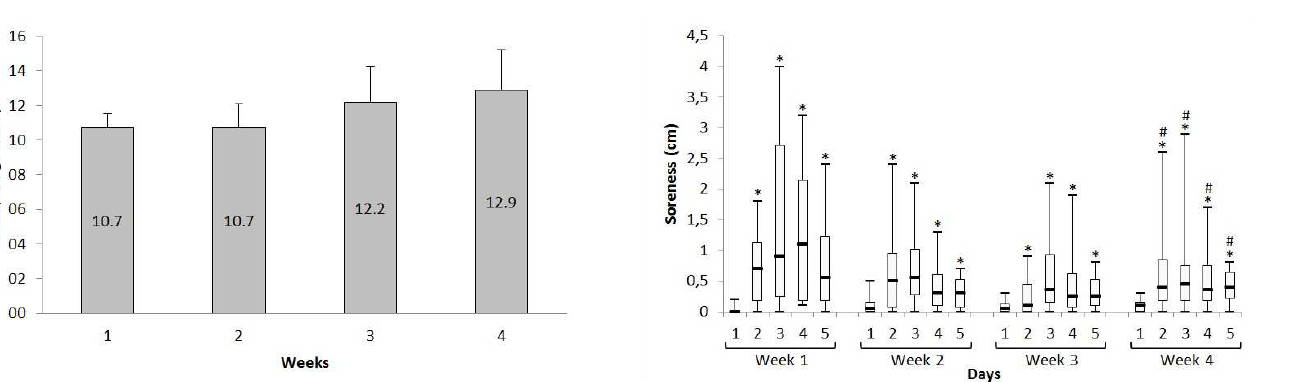
Figure 1. Oxygen uptake (VO ) values obtained during the last Figure 4. Soreness (SOR) values assessed every training day. * p < 2 training session of weeks 1-4. Data are represented by mean + 0.05 compared to the first training session of week one. # p < 0.05 SD. compared to the same training session of the first